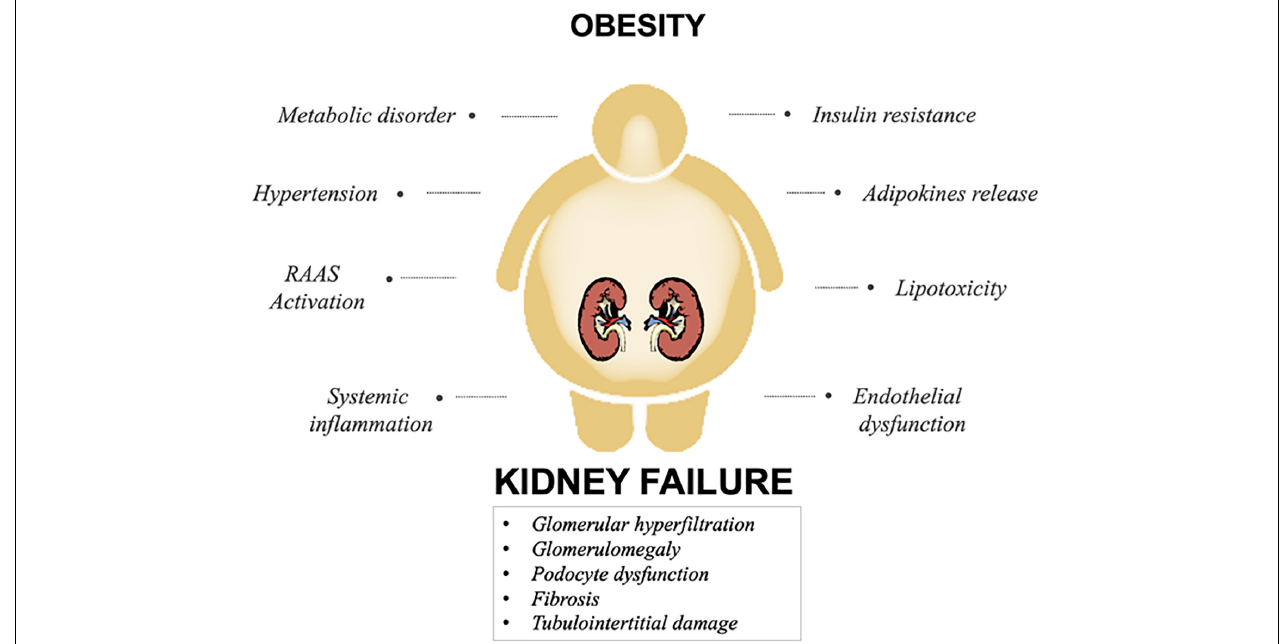
FIGURE 1 | Principal mechanisms involved in obesity-related kidney disease. A combination of several mechanisms involved in obesity, impact on renal function, culminating in kidney